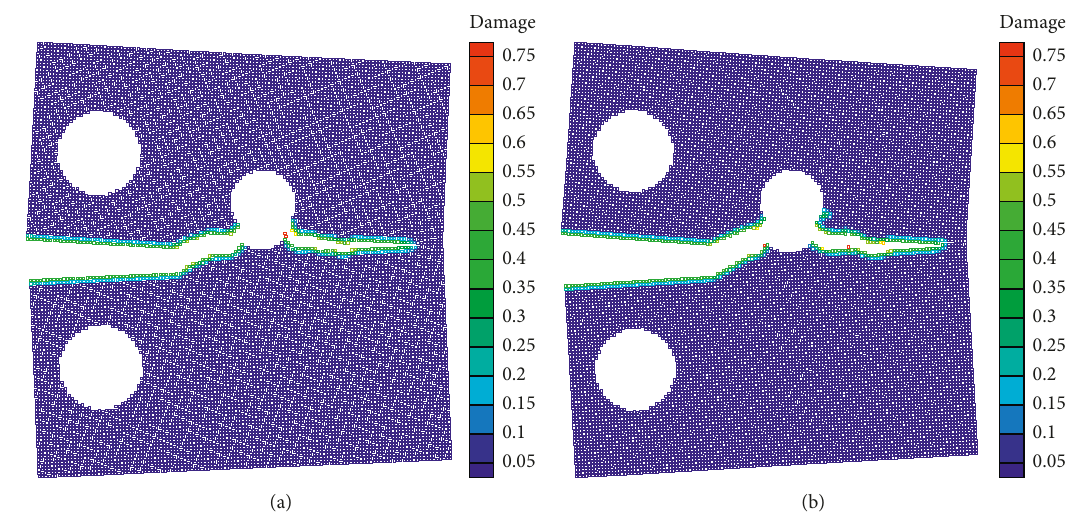
Figure 12: Quasistatic rack paths for (a) sample 2 and (b) sample